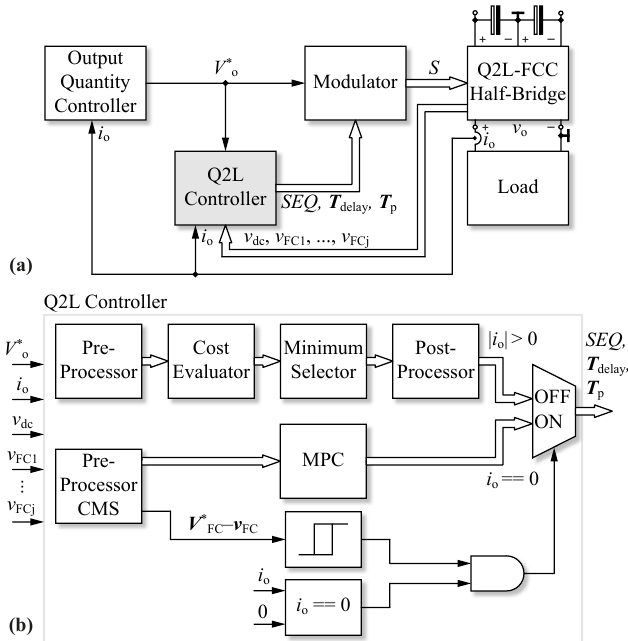
Figure 6. ( a ) Block diagram of an FCC HB with Q2L voltage balancing controller and modulator. Note that the output quantity (e.g., load current) controller is not in this paper’s scope and hence we consider an exemplary fixed duty cycle of d = 50%. ( b ) Control block diagram of the proposed load-independent Q2L voltage balancing